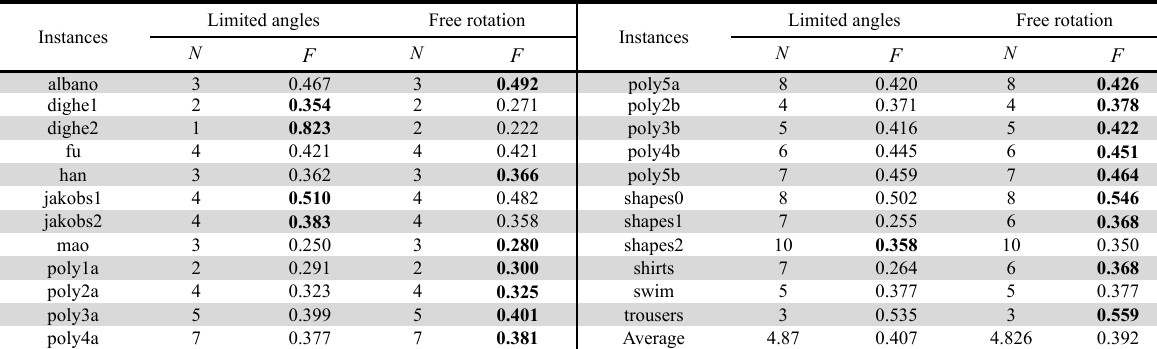
Analysis of Nest-MB instances at different rotation angles